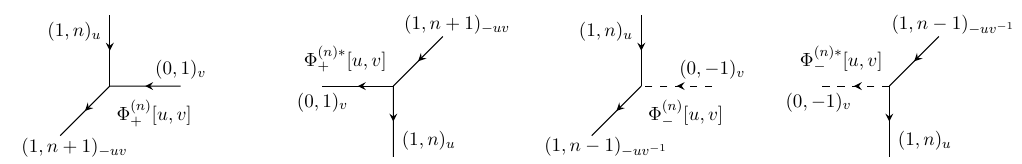
[ u, v ] and Φ ( n ) ∗ [ u, v ] . The dashed line represents the representation with negative Figure 2 . Φ ( n ) ± ± level (0 , − 1) . The arrows represent the order of the operator. For example, the intertwiner Φ ( n ) v is a map (0 , 1) (1 , n ) (1 , n + 1) and thus the arrow is as the figure. v ⊗ u → − uv